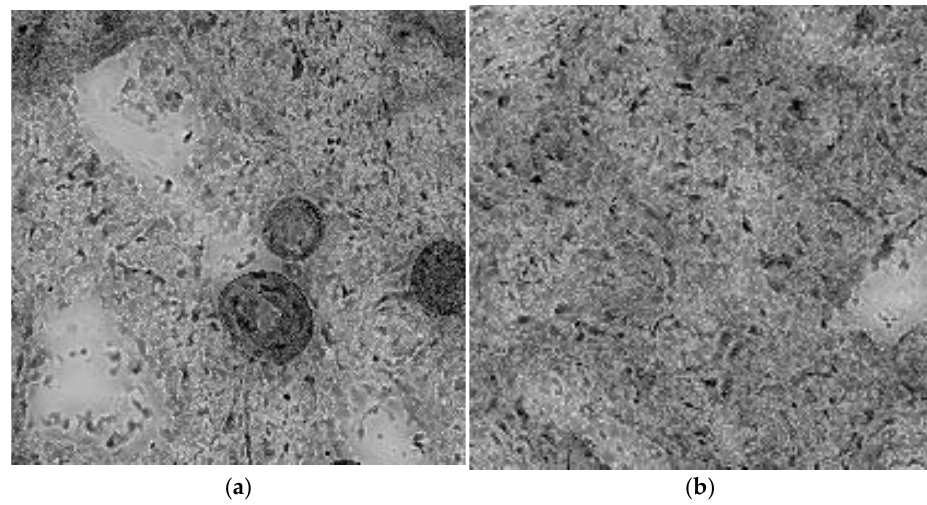
Figure 5. Images of pixel brightness displaying the value of the Helder exponents (Algorithm Step